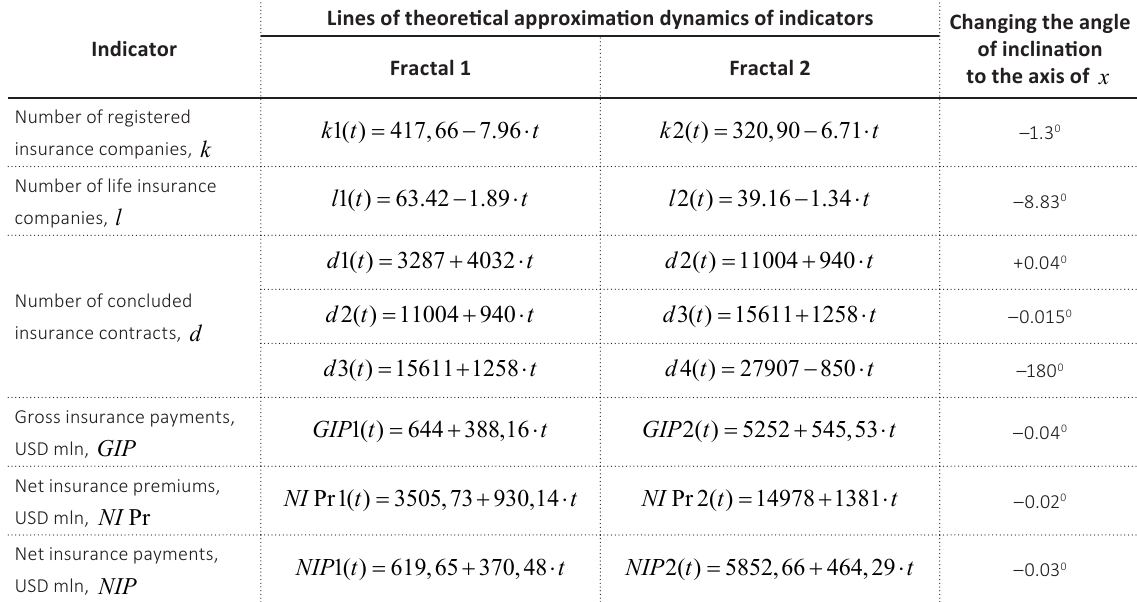
Table 2. Theoretical approximation of lines of the insurance market dynamics by first-order fractals Lines of theoretical approximation dynamics of indicators Changing the angle Indicator Fractal 1 Fractal